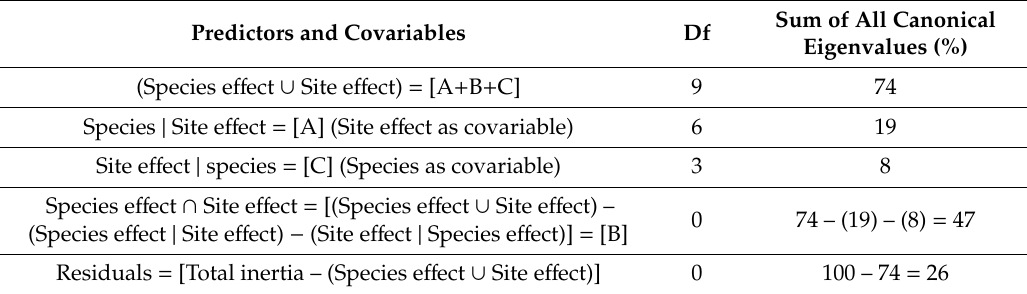
Table 2. Summary table showing variation partitioning and calculation of benthic fluxes explained by macrofauna species, sites, and joined e ff ect. Explained variance can be portioned in [A], [B], and [C]. [A] = percentage of variability merely explained by macrofauna; [C] = percentage of variability merely explained by location; [B] = percentage of variability explained by a synergistic e ff